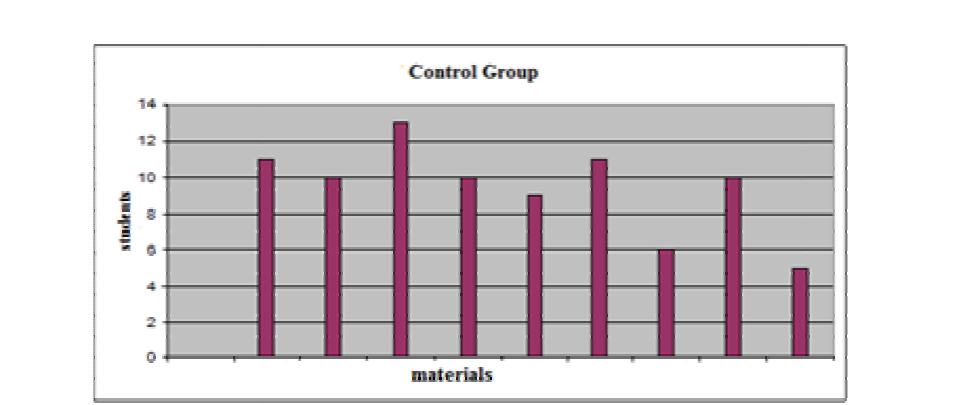
Figure 2: Task Completions of Control Group